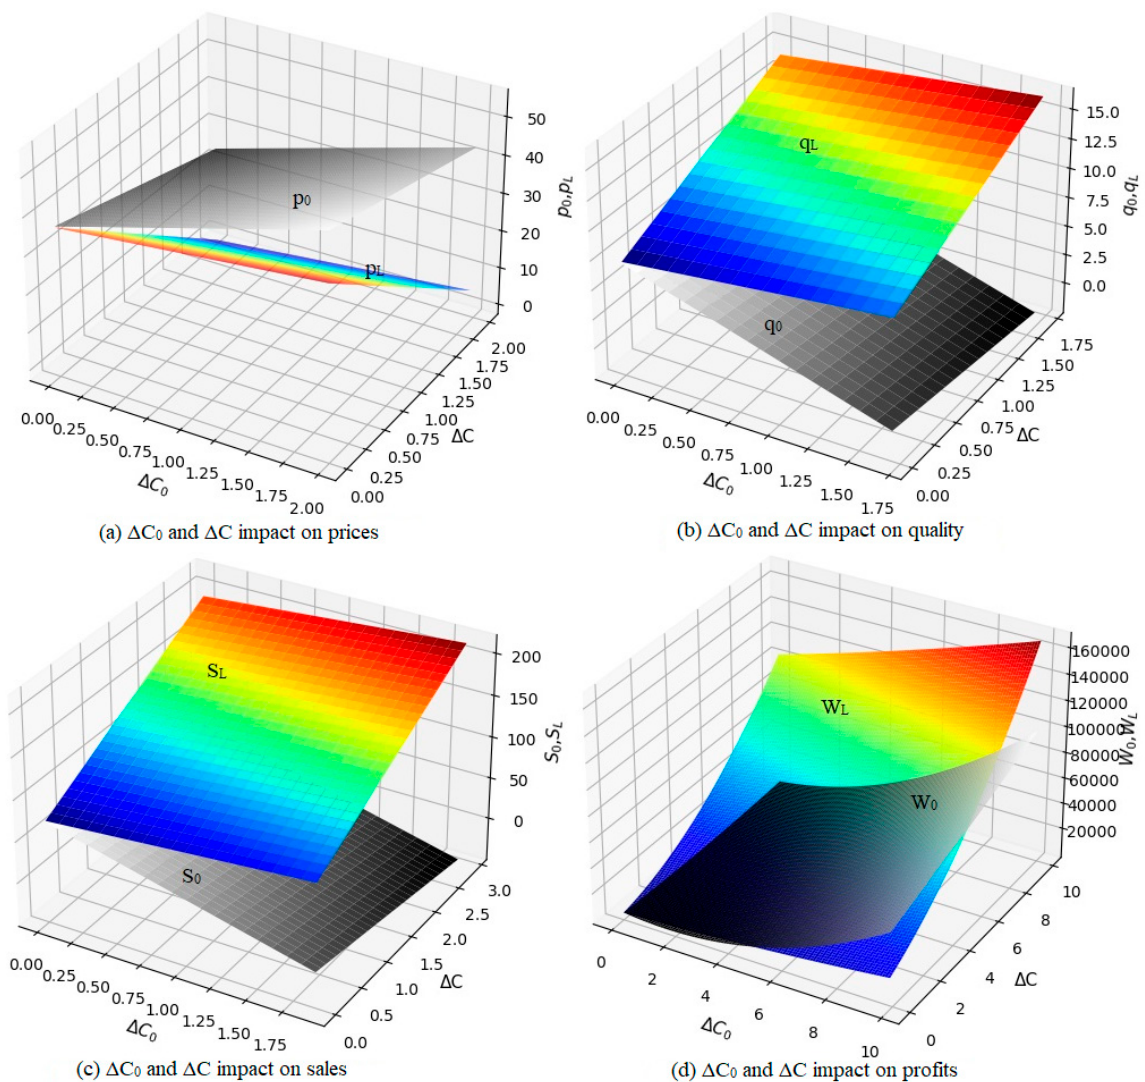
Figure 4. The parameters of the two products are affected by Δ C 0 and Δ C.